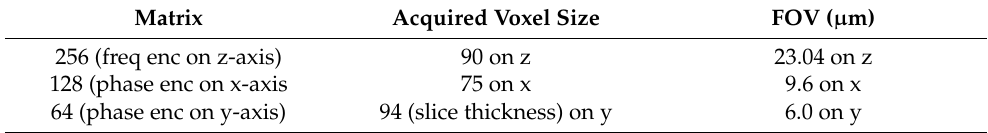
Table A2. 3D MGE acquisition geometry.